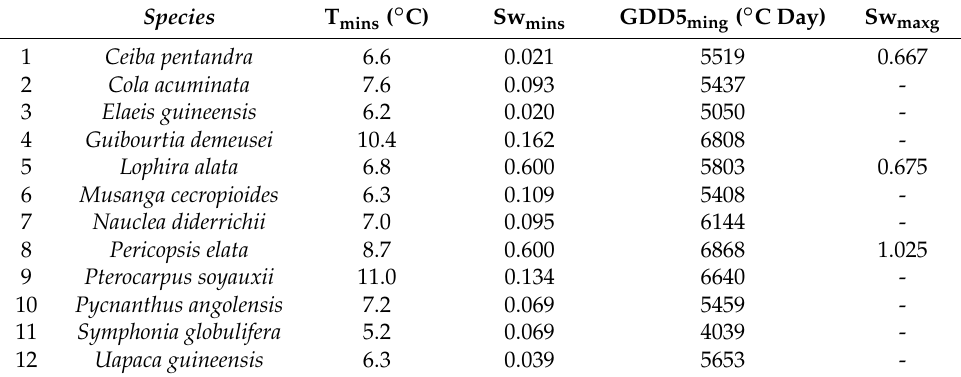
Table 3. Species climatic tolerances to stress (minimum temperature, T mins , and, minimum soil water, SW mins ) and requirements for germination (minimum yearly sum of growing degree-days above 5 ◦ C GDD5 ming , and, for drought deciduous species, maximum soil water of the driest month, SW maxg ). Soil water thresholds refer to available soil water in relative units, i.e., in terms of the